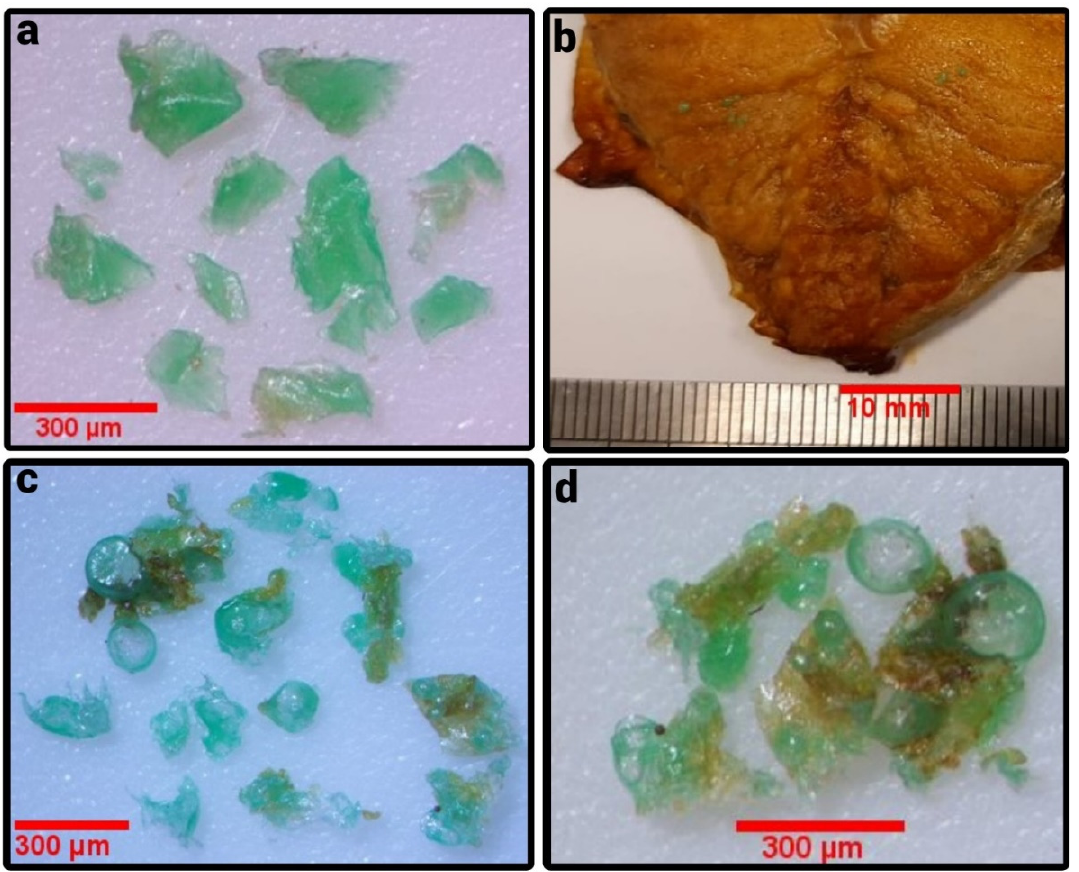
Figure 3. ( a ) MP stemming from cut raw king mackerel ( Scomberomorus cavalla ) after digestion with aq. KOH; ( b ) part of a grilled king mackerel piece with adhering MPs; ( c , d ) MPs isolated from grilled king mackerel. Please unify if a , b , c ,…..will be after or before the caption. Here it is before other figures are after.